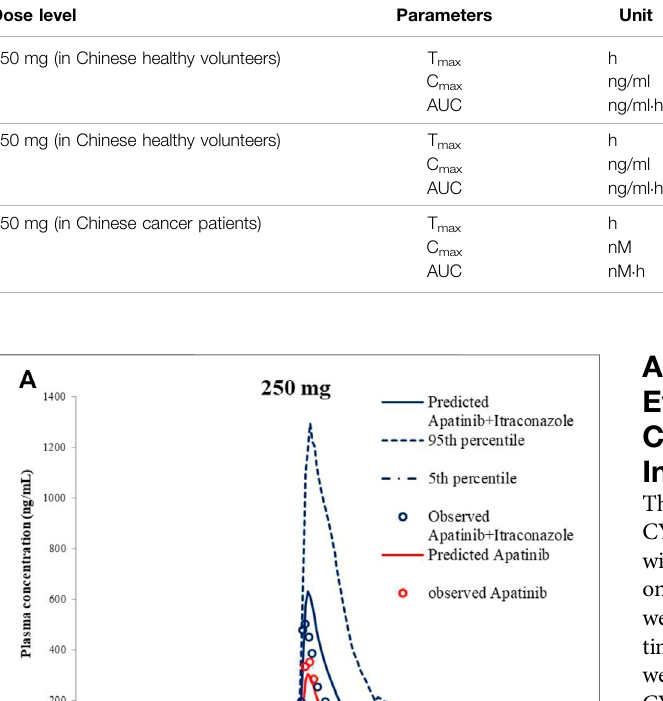
TABLE 3 | Comparison of model-predicted main pharmacokinetic parameters (C max , T max , and AUC) to the observed data of apatinib mesylate tablet Dose level